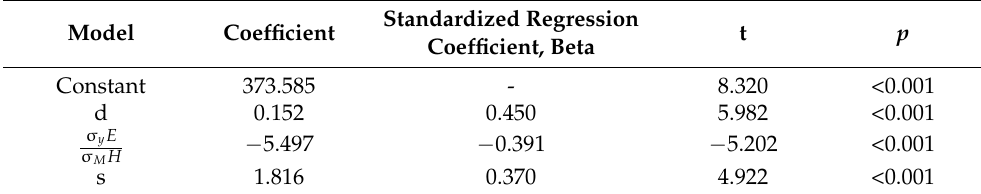
Table 14. Coefficients of the regression model for multi-asperity test.